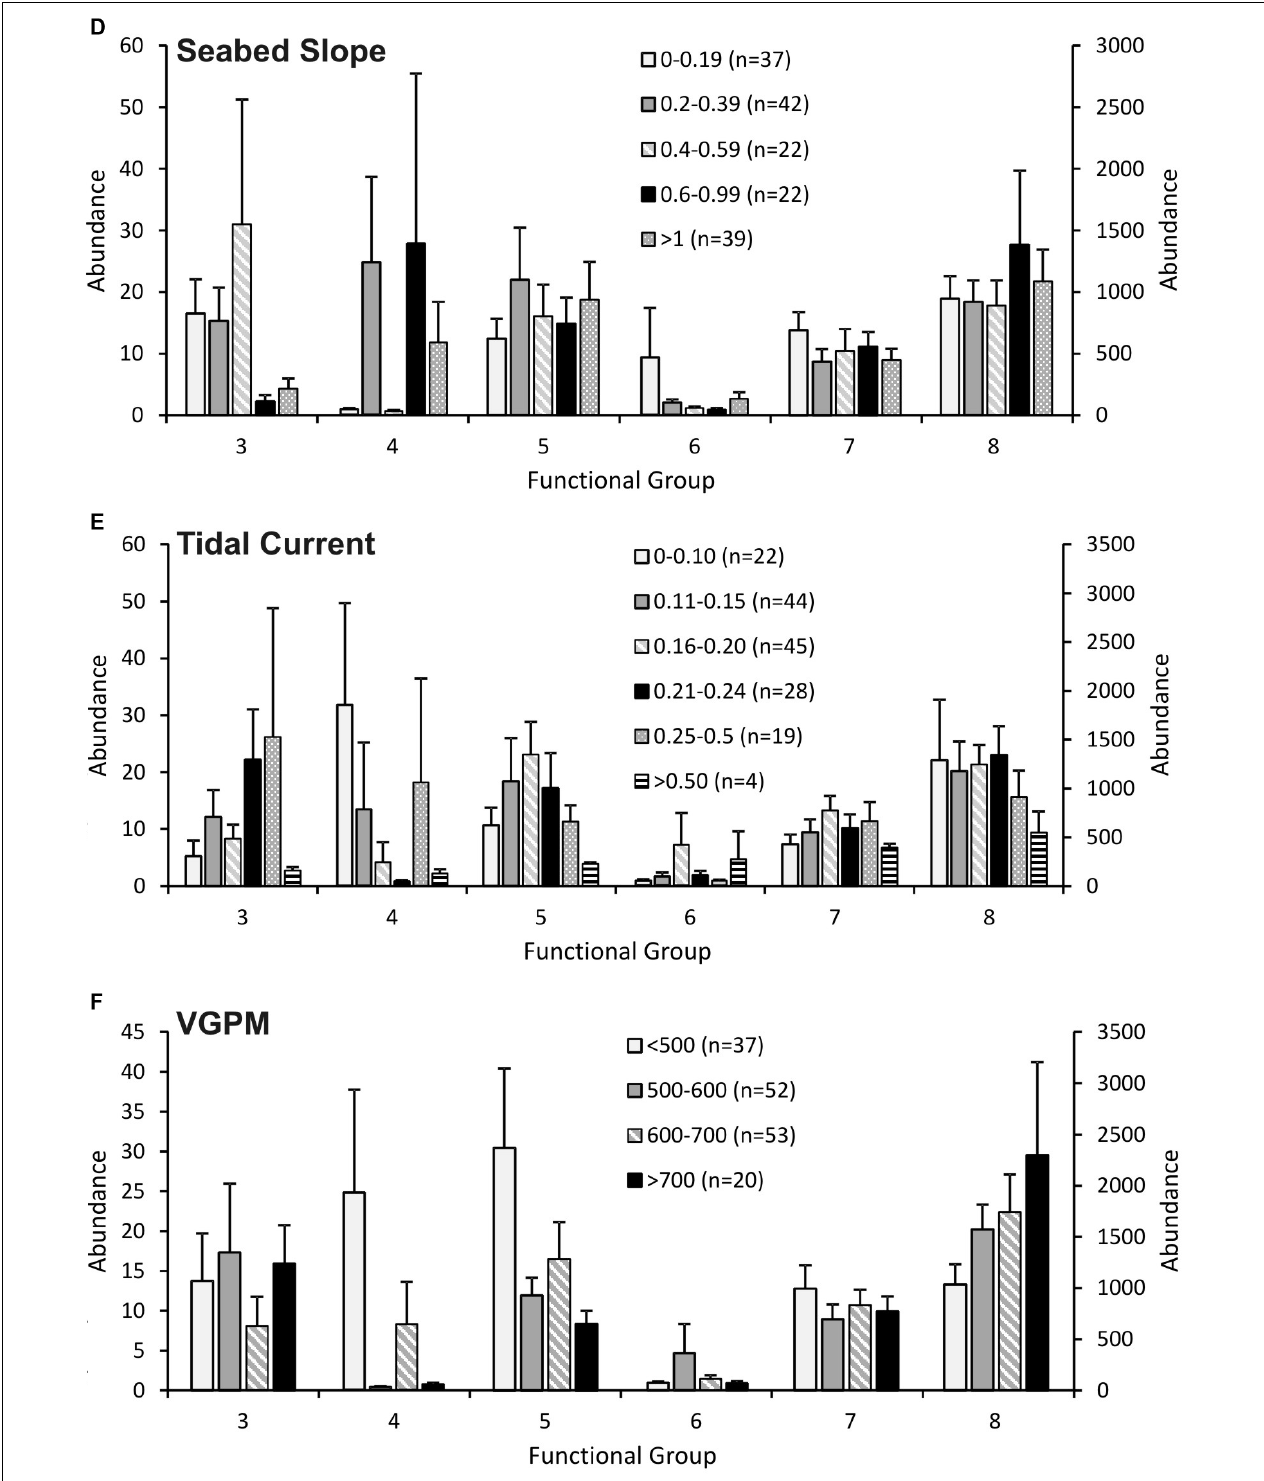
FIGURE 3 | Abundance of each functional group for the Ocean Survey 20/20 offshore dataset for environmental variables: (A) depth; (B) seabed roughness; (C) sediment; (D) seabed slope; (E) tidal current; (F) VGPM as indicator of primary productivity. Abundance values for groups 4 and 6 are plotted on the secondary y axis. Error bars represent one standard